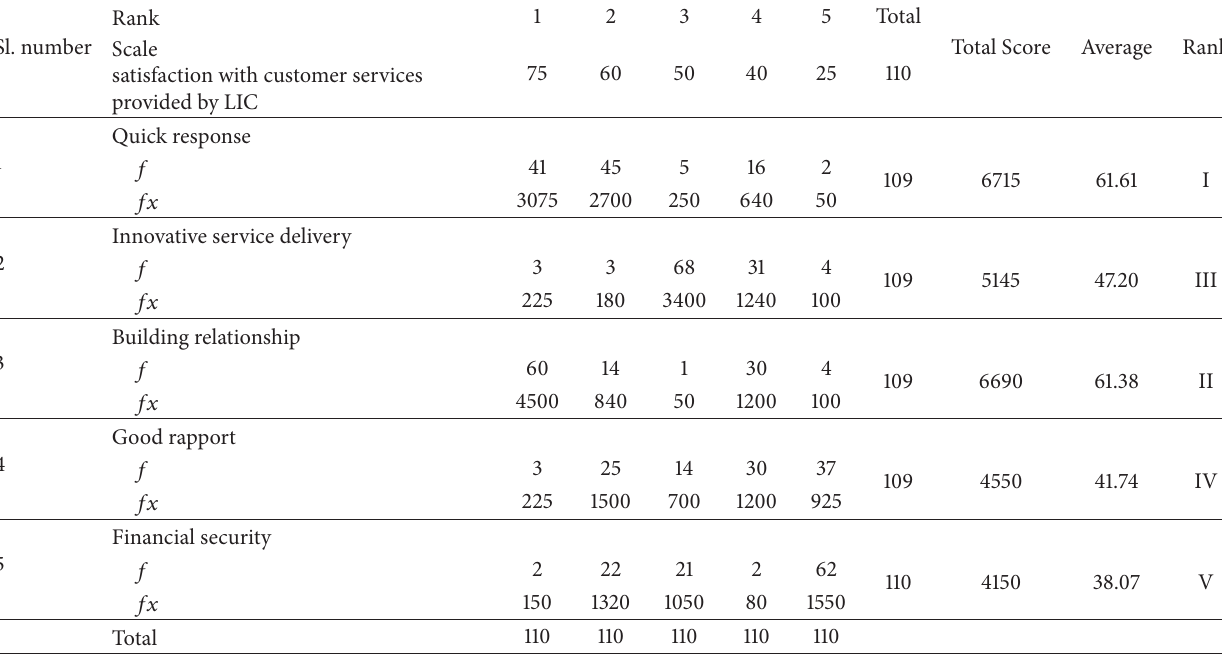
Table 5: How you are satisfied with the services provided by banks. Sl. number